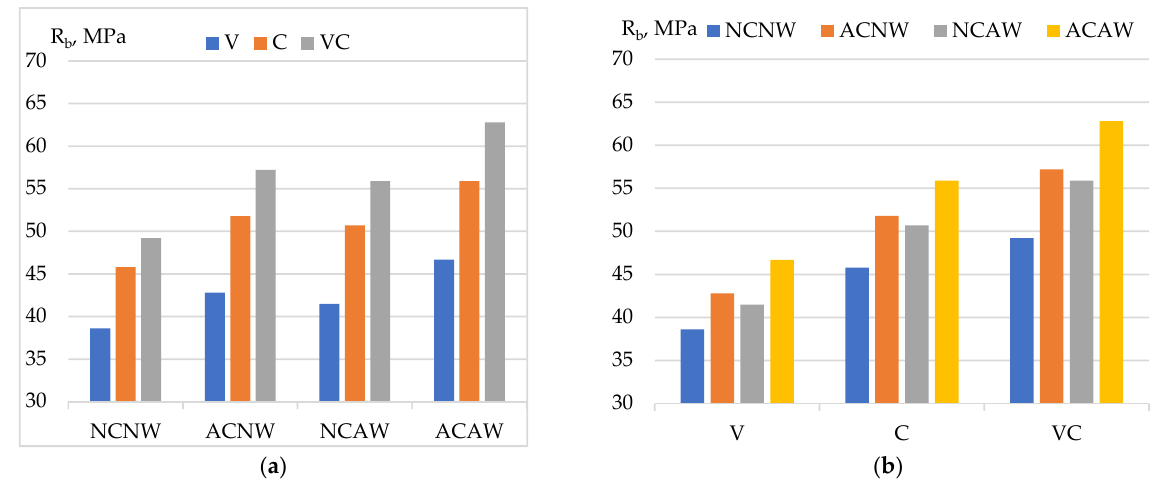
Figure 6. Dependence of the prismatic strength of concrete: ( a ) on the type of activation, ( b ) on the type of technology of its manufacture.